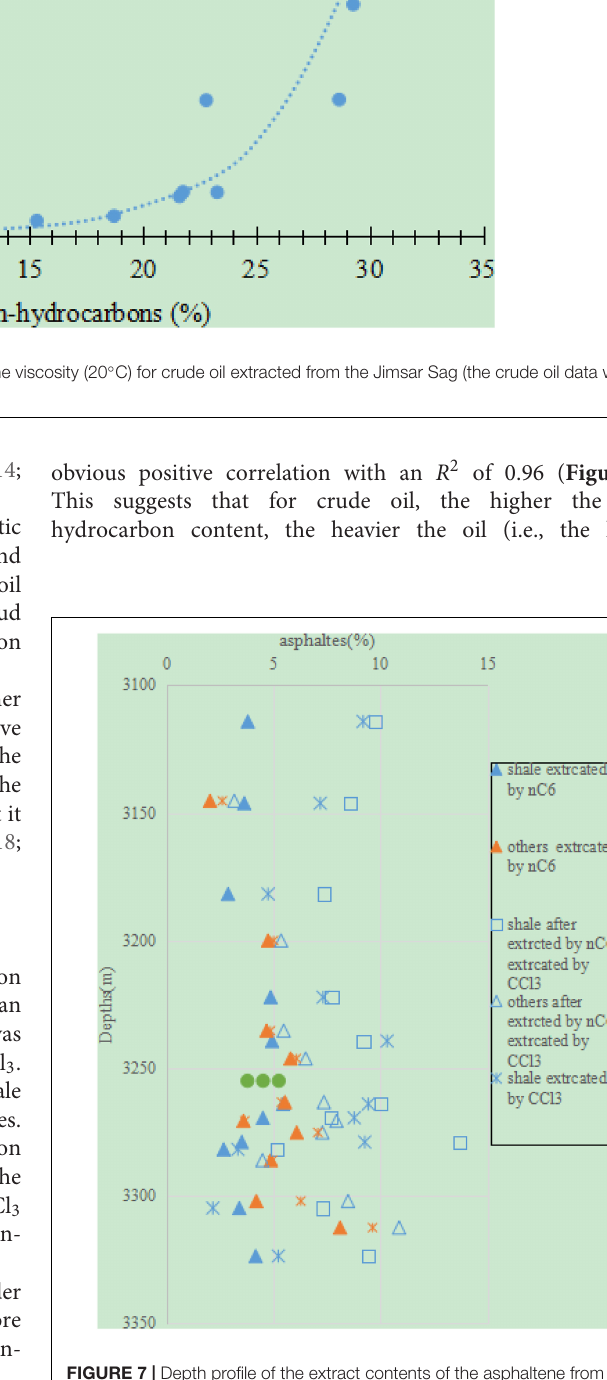
FIGURE 7 | Depth profile of the extract contents of the asphaltene from the mud shale versus the non-mud shale samples after different extraction